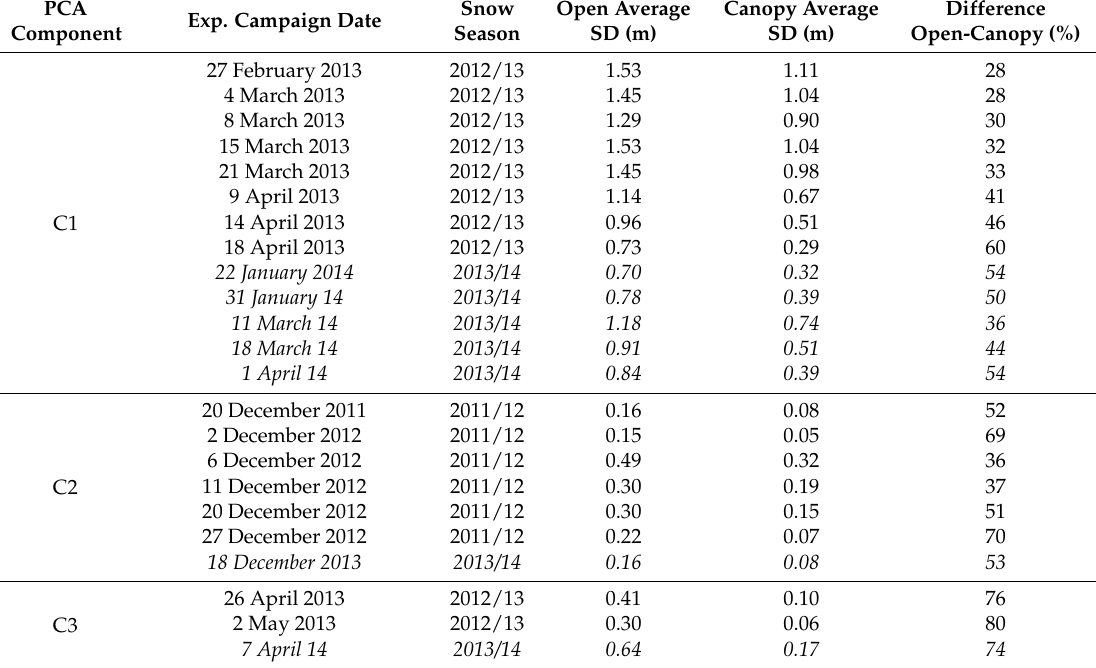
Table 1. Survey dates classified into the three principal component analysis (PCA) components. For each date the mean values for the Open and Canopy areas, and the difference between them, are provided. Survey dates and data following pruning are shown in